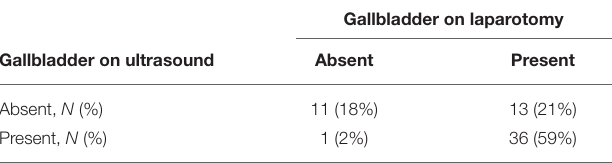
TABLE 1 | Sonographic comparison with intraoperative findings of gallbladder.